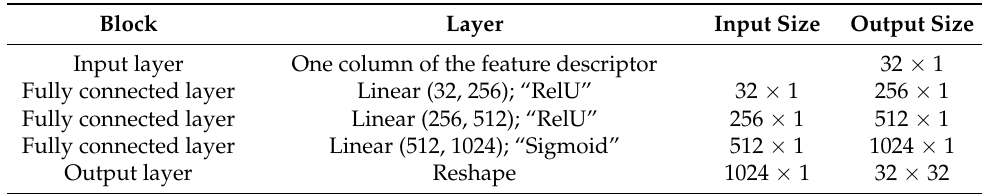
Table 1. Model specifications and parameters of the decoder.